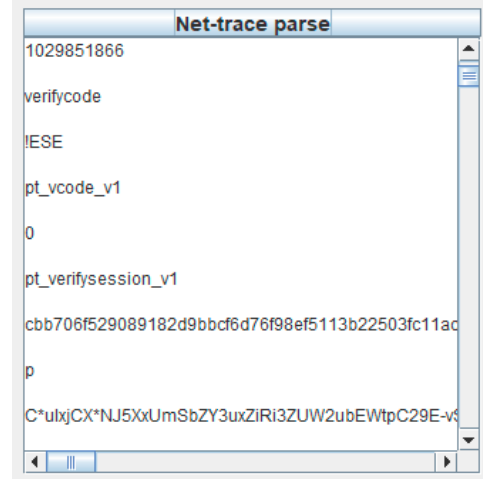
Figure 25. Parse result of the intercepted request message.